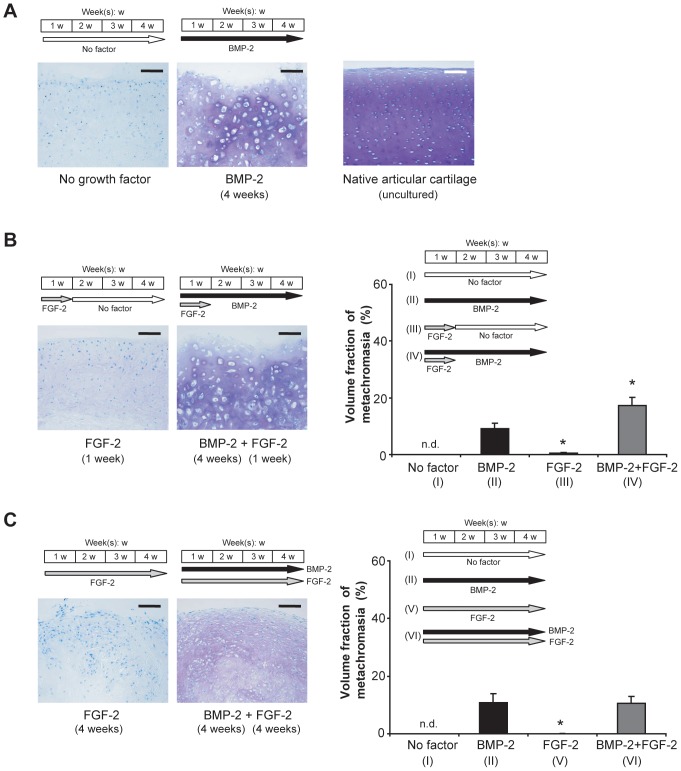
Influence of FGF-2 on the BMP-2-induced chondrogenesis of synovial explants (histochemical and histomorphometric analysis).A–C: Light micrographs of Toluidine-Blue-stained sections through bovine explants that had been cultured for 4 weeks under the indicated stimulation conditions, and graphs depicting the volume fraction of metachromasia in each case. In A, an image of metacarpal-joint cartilage is included as a positive control. BMP-2 was applied at a concentration of 200 ng/ml, and FGF-2 at one of 10 ng/ml. In the graphs, mean values for n = 4 animals (4 explants in each case) are represented together with the SEM. n.d.: not detectable; *: p<0.05 vs. “BMP-2” alone. Bars = 100 µm.